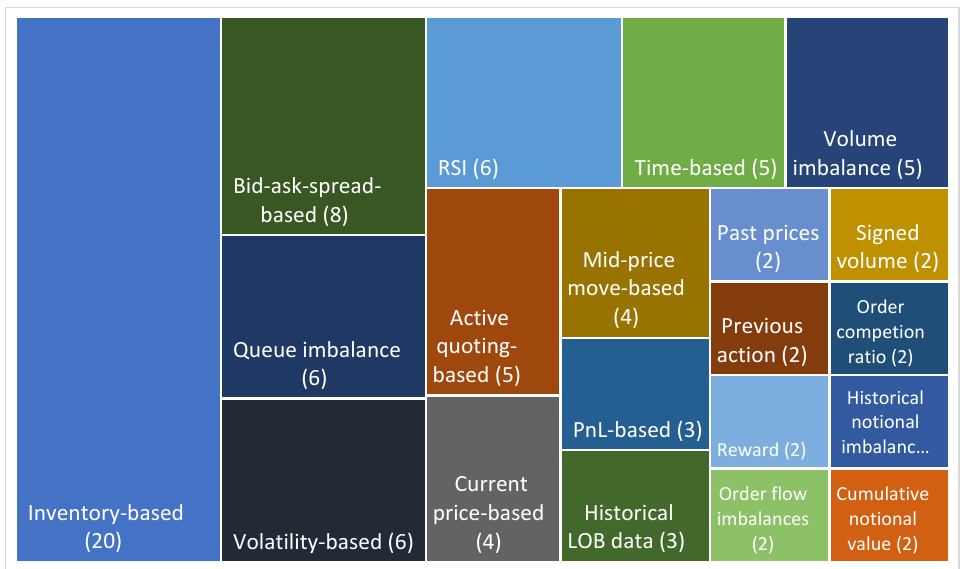
Figure 5. Overview of the most commonly used state space